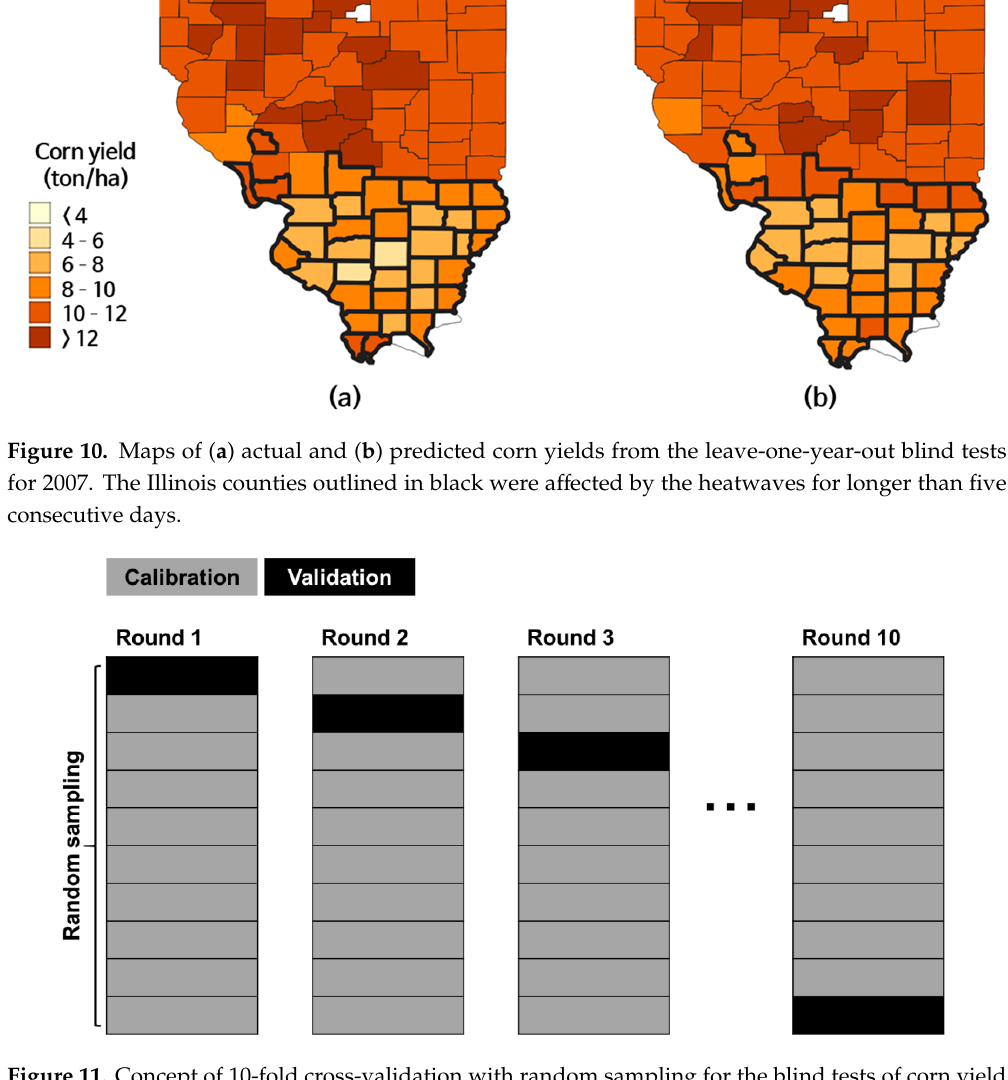
Figure 11. Concept of 10-fold cross-validation with random sampling for the blind tests of corn yield prediction during 2006–2015. Table8. Summaryofcomparisonsbetweenleave-one-year-outand10-foldblindtestsforthedeepneural network models for prediction of corn yield under drought and heatwave conditions during